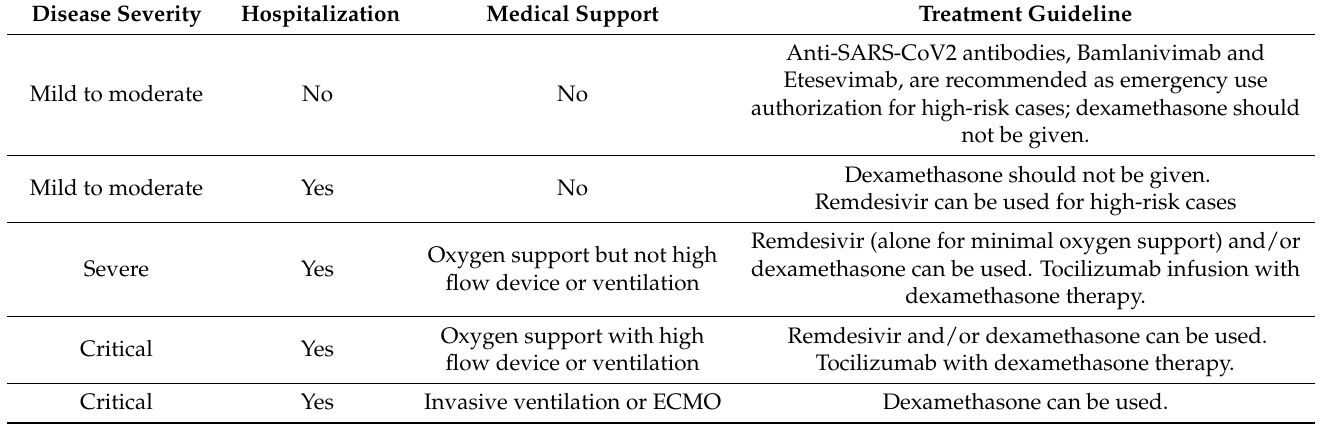
Figure 1. Canonical glucocorticoid receptor signaling underpinning the mechanism of action of corticosteroids. Cortico- steroid (CSTs) exert their downstream effects on host cells by activating glucocorticoid receptor (GR), which modulate the transcription of several target genes. The binding of CST with GR leads to conformational changes in GR; the GR-complex translocate to the nucleus, where GR binds to GR-response elements, including positive (blue arrows) and negative (red lines) transcriptional regulators, receptors and enzymes. The downstream effects, including mitochondrial functions, metabolism, stress response, and anti-inflammatory effects of CST, are mediated through differential regulation of various effector molecules (dotted lines with arrow). Table 1. Summary of COVID-19 therapy recommended by the United States–National Institute of Health (US-NIH) and US-Center for Disease Control (US-CDC). Data updated on 12 March 2021. ECMO—extracorporeal membrane oxygena- tion.